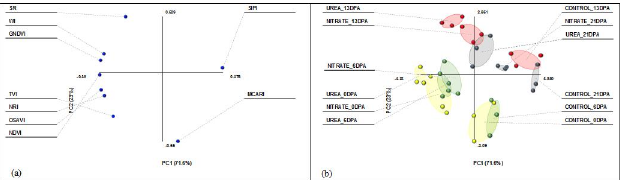
Fig 7. Two dimensional principal component analysis (PCA) in 2012. (a) loading plot for the 9 variables (VIs indices: NDVI, GNDVI, WI, OSAVI, SIPI, NRI, SR, MCARI and TVI); (b) score plot for the 12 treatments (CONTROL_0DPA, CONTROL_6DPA, CONTROL_13DPA, CONTROL_21DPA, UREA_0DPA, UREA_6DPA, UREA_13DPA, UREA_21DPA, NITRATE_0DPA, NITRATE_6DPA, NITRATE_13DPA, NITRATE_21DPA) obtained as a combination of the 3 N treatments (CONTROL, UREA and NITRATE) at 4 sampling dates during grain development (0, 6, 13 and 21 days post-anthesis (DPA)). Further explanations on VI s , sampling dates/phenological stages and N fertilization treatments are provided in S2 Table and in the